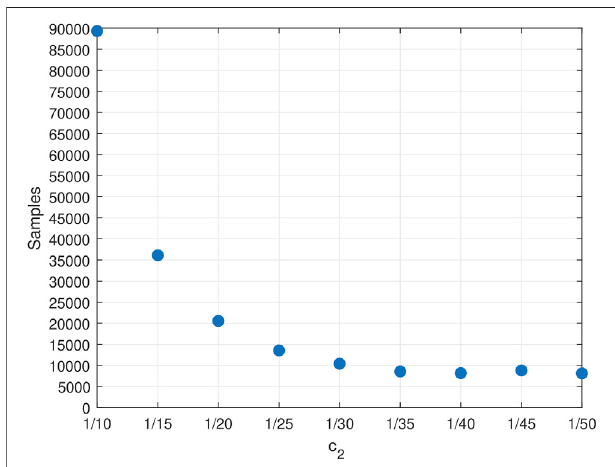
FIGURE 5 | The required samples by UCB Q-learning algorithm.